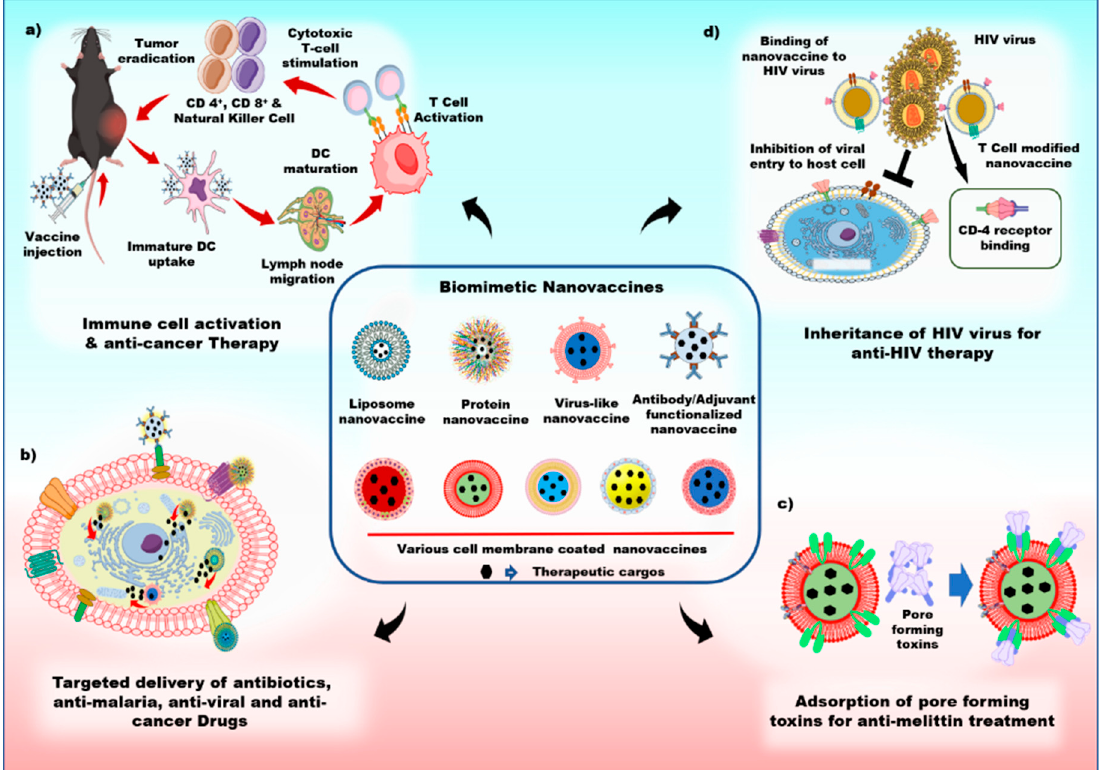
Figure 4. Schematics of the various applications of biomimetic nanovaccines. a )